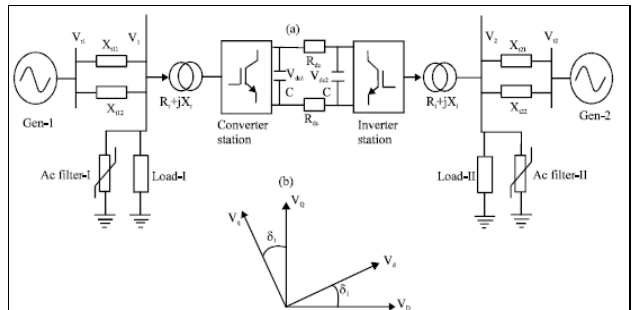
Fig. 1. VSC-HVDC scheme design